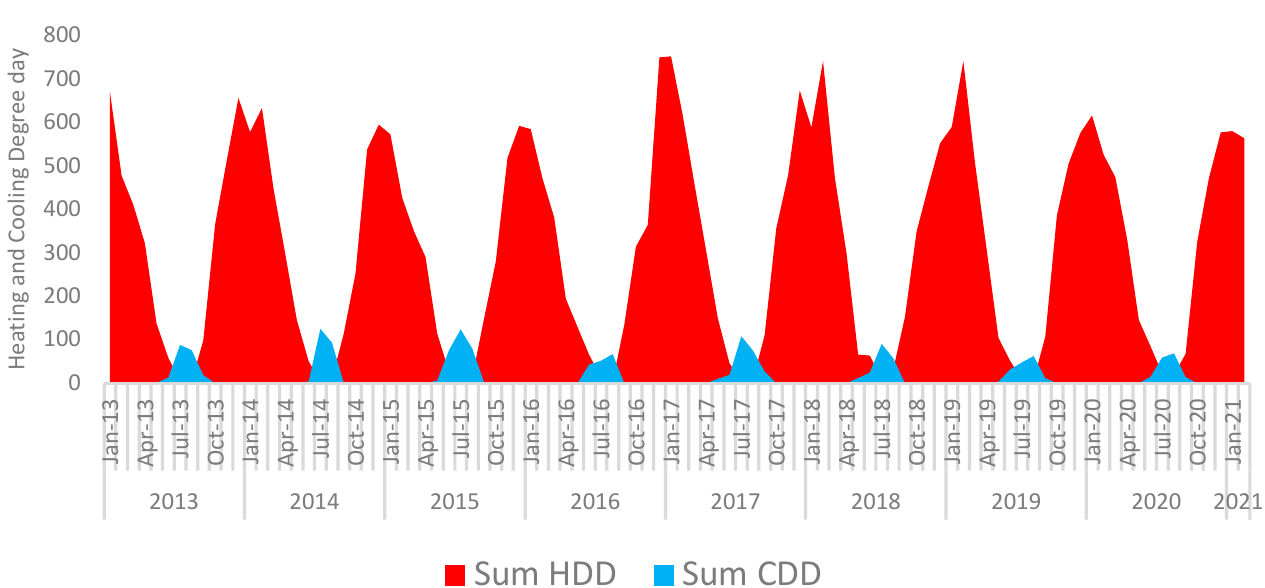
Figure A1. Student enrollment in the University of British Columbia Okanagan (UBCO) in the past five years.